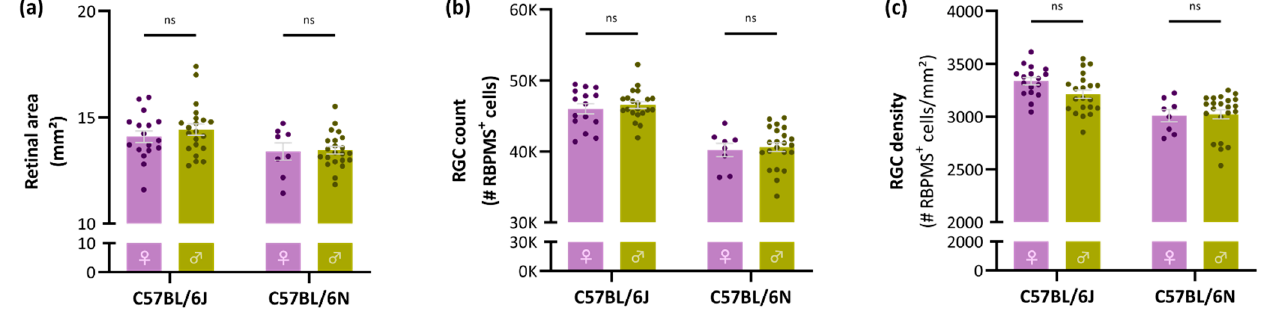
Figure 2. Retinal area, total RGC count and global RGC density per sex in C57BL/6J and -N mice. Retinal area ( a ); RGC number ( b ); and density ( c ) did not differ between female ( n = 17 for C57BL/6J, 8 for C57BL/6N) and male ( n = 21 for C57BL/6J, 22 for C57BL/6N) mice and is thus not sex-dependent. Two-way ANOVA with Tukey’s post hoc test; ns = non-significant.